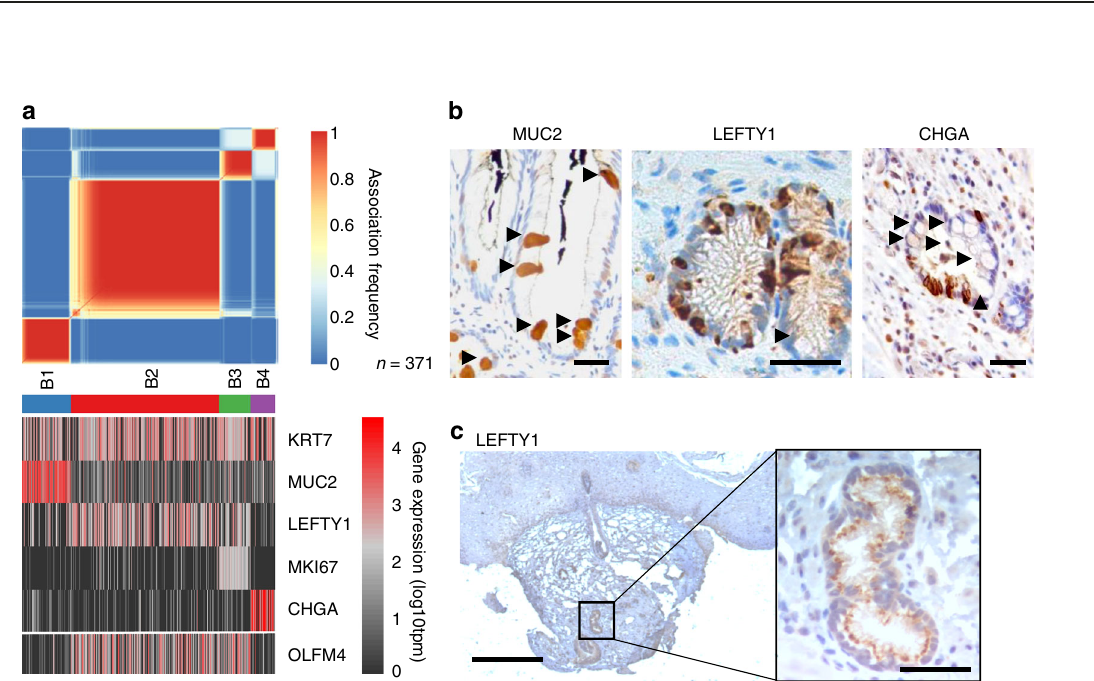
Fig. 2 LEFTY1 and OLFM4 are mainly expressed in Barrett ’ s oesophagus cells that do not express differentiated secretory cell markers. a Upper panel, cluster consensus matrix of BO cells from 4 BO patients ( n = 371 cells). Blue-to-red colours denote the frequency with which cells are grouped together in 250 repeat clusterings of simulated technical replicates (see Methods). Clusters (B1-B4) are indicated by the coloured bars below. Lower panel, heatmaps showing expression of selected functionally relevant genes that are differentially expressed between cell clusters (>4 fold change, FDR <1e-5). b Immunohistochemical staining of MUC2, LEFTY1 and CHGA in sections derived from the same BO resection specimen. Black arrows indicate goblet cells on all sections (positively stained for MUC2; negative for LEFTY1 and CHGA). Scale bars are 50 µ m. c Immunohistochemical staining of LEFTY1 in an OSG from a normal squamous endoscopic biopsy obtained from a patient with BO. Scale bars are 300 µ m and 50 µ m in enlarged image